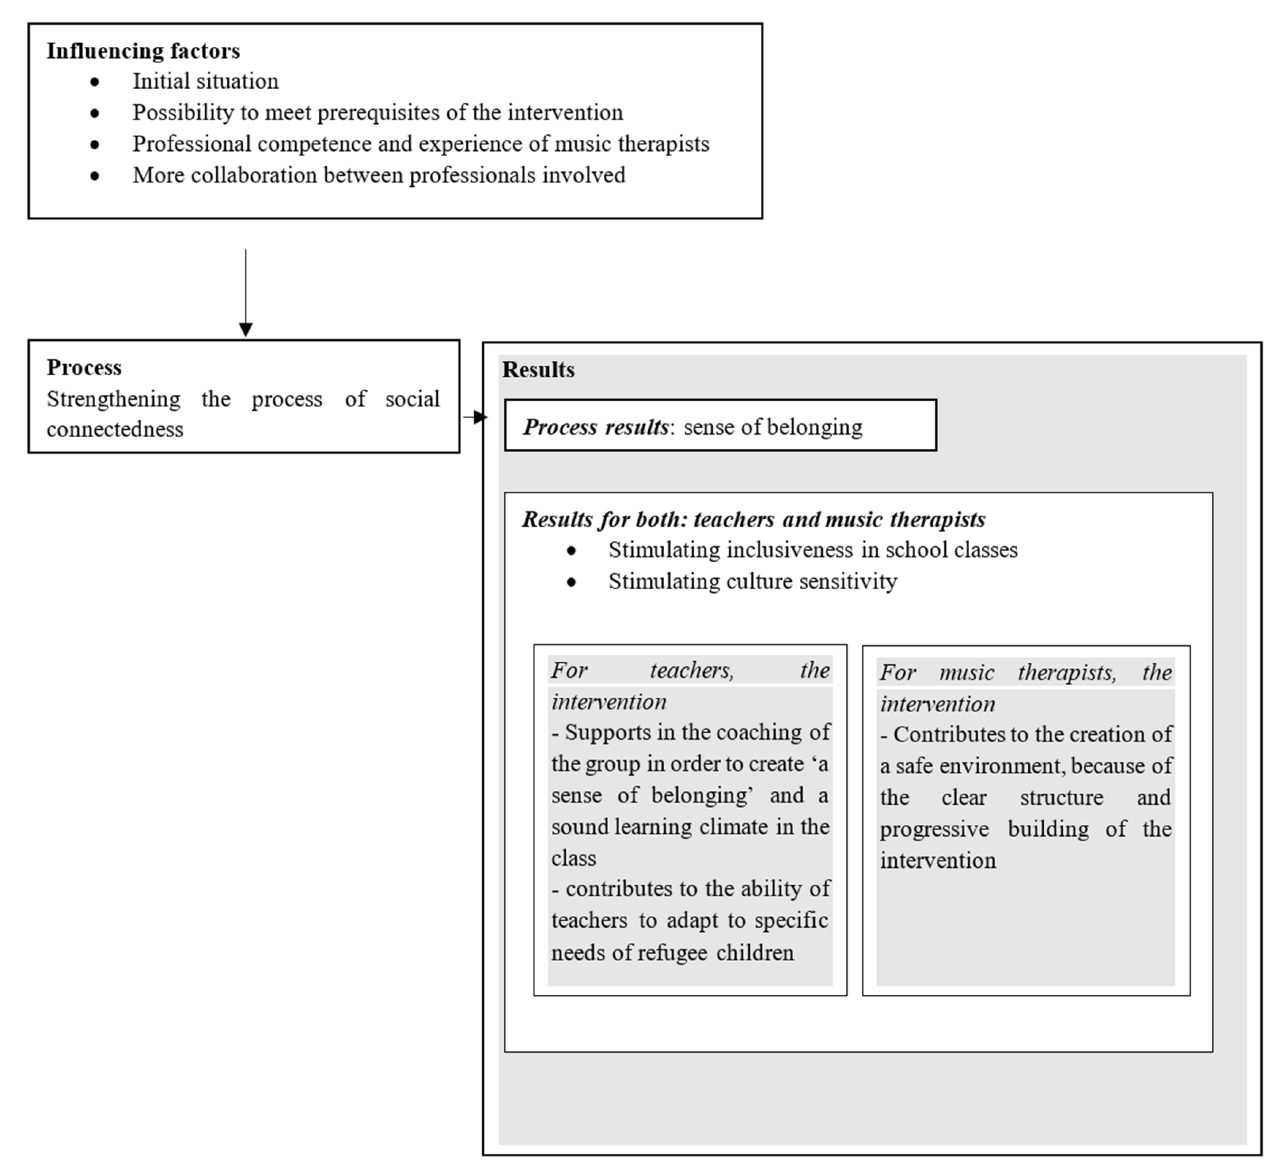
Figure 2. Process and process results of the interventions Safe & Sound.